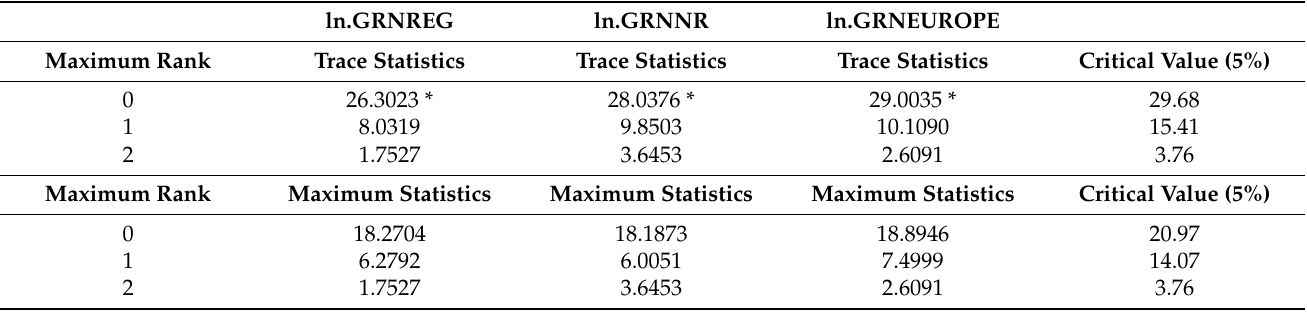
Table 5. Johansen test for